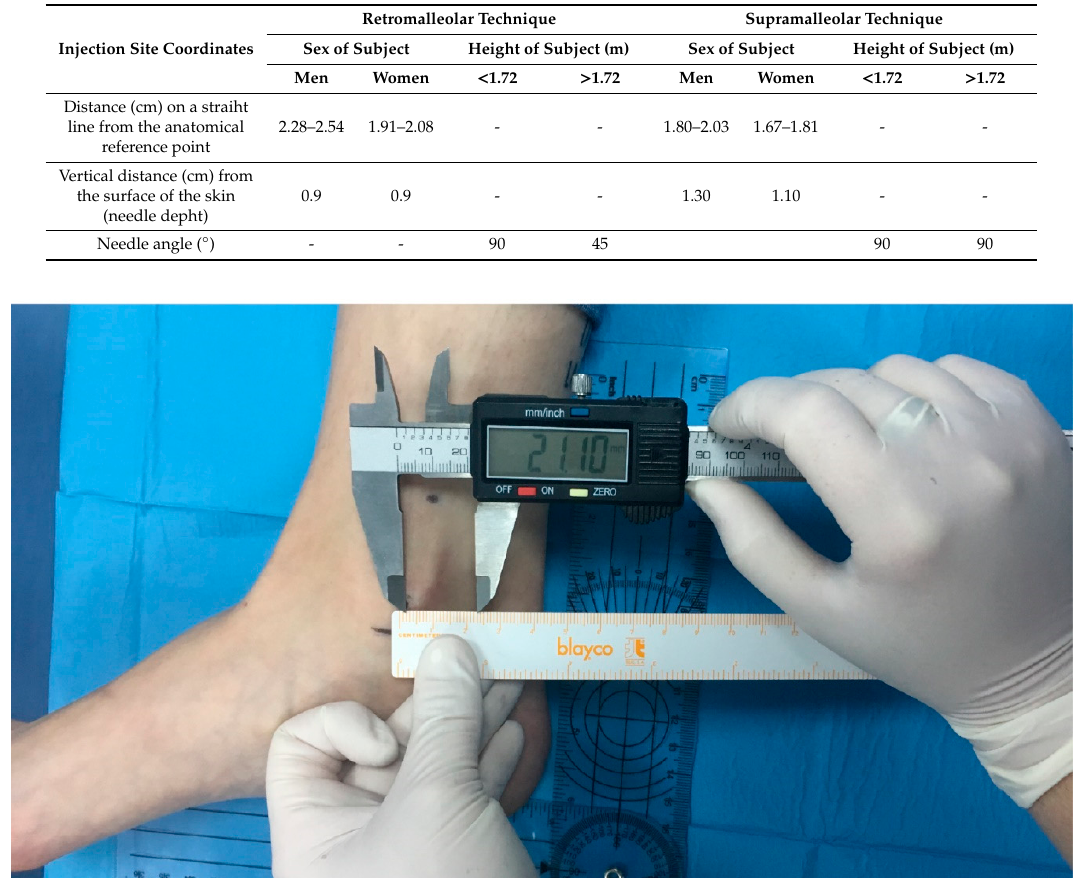
Figure 2. Retromalleolar injection distance coordinate. Calculation of the target injection site, based on the most prominent point of the medial malleolus, measured with a digital caliper.